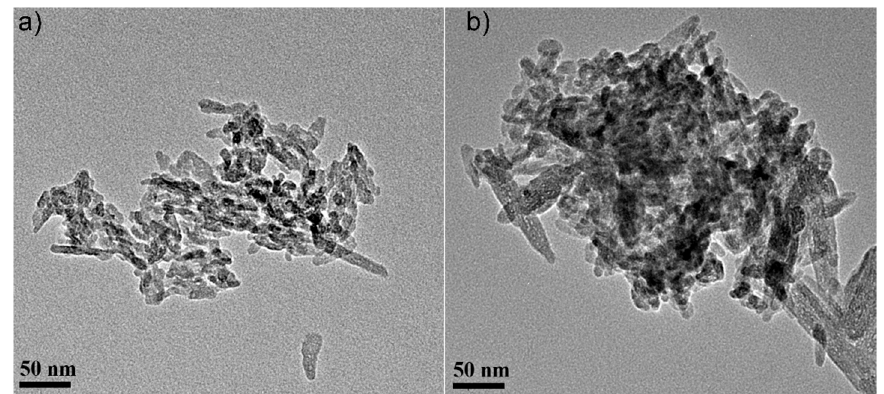
Figure 5. Transmission electron microscopy (TEM) micrographs of the HAp powders before ( a ) and after zinc adsorption from aqueous solutions containing zinc ions (HApD) in a concentration of 50 mg/L ( b ). Scale bar: 50 nm.